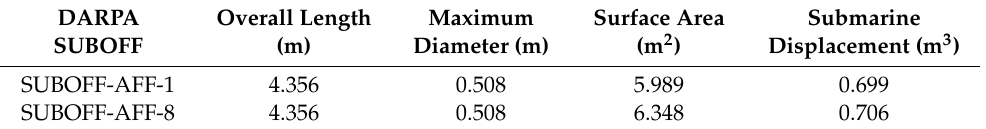
Figure 2. Schematic diagram of SUBOFF-AFF-8.